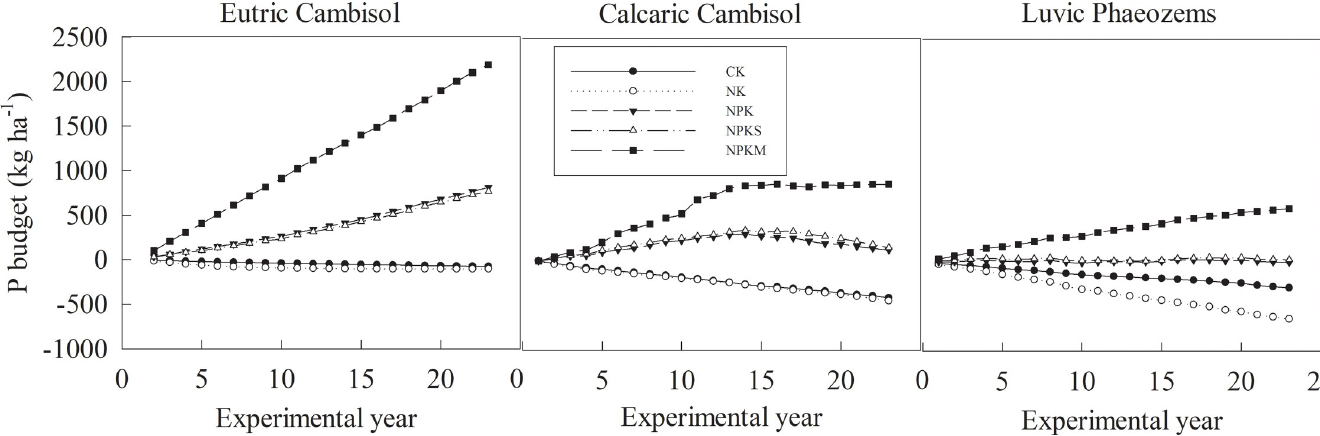
Fig 2. P budget of soils under different fertilizer application treatments. CK: unfertilized control; NK: nitrogen and potassium; NPK: nitrogen, phosphorous, and potassium; NPKS: nitrogen, phosphorous, potassium and straw; and NPKM: nitrogen, phosphorous, potassium and manure (NPKM).